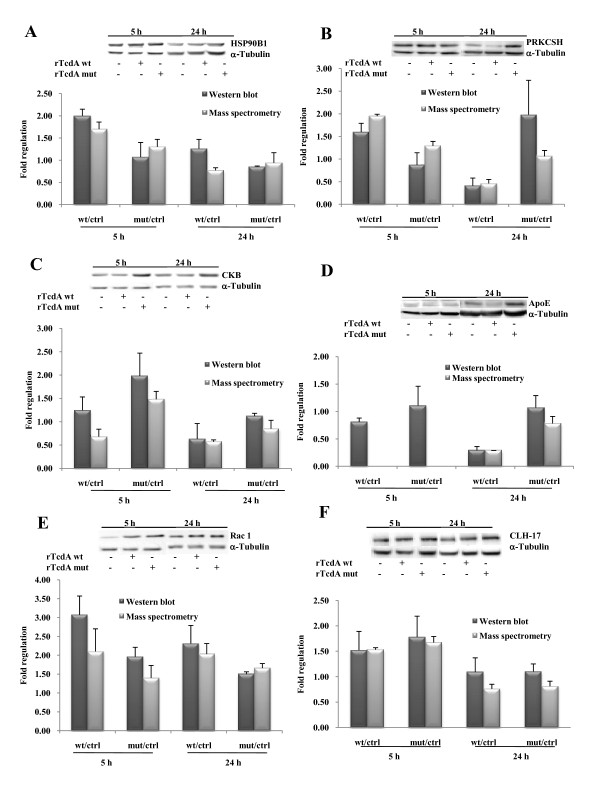
Western blot analyses of regulated proteins. Caco-2 cells were treated with rTcdA wt or mutant rTcdA (500 ng/mL) for 5 h or 24 h. After fractionation the cytosolic proteins were separated on 12% SDS-PAGE and probed with antibodies against regulated ptoteins. The western blot quantitation was performed on a Kodak Image Station 440 CF by analysis with the Kodak 1D Image software, for normalization of samples α-tubulin was used. The bars represent fold regulation factors referred to values of control samples (mean values + SD, n ≥ 3). The mass spectrometry data of corresponding proteins were shown to compare the results of this study. A) Endoplasmin (HSP90B1); B) Glucosidase 2 subunit beta (PRKCSH); C) Creatin kinase b-type (CKB); D) Apolipoprotein E (ApoE); E) Rac1; F) Clathrin, heavy chain 1 (CLH-17).